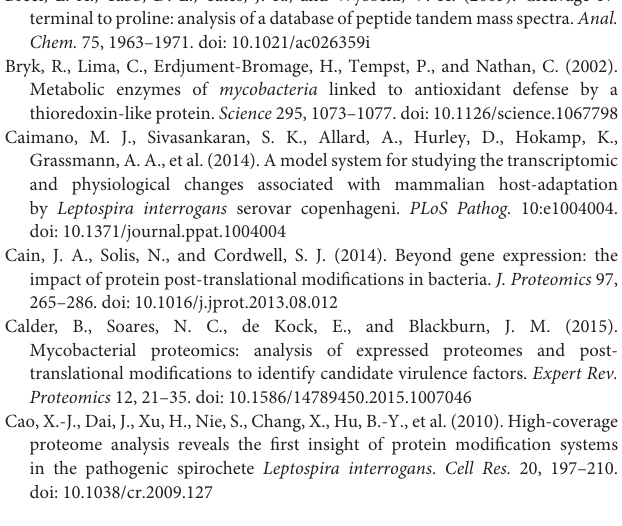
Supplementary Figure 1 | Two-dimensional gel electrophoresis of leptospires. As shown in Figure 1 but without labels. Supplementary Table 1 | List of all differentially expressed proteins.